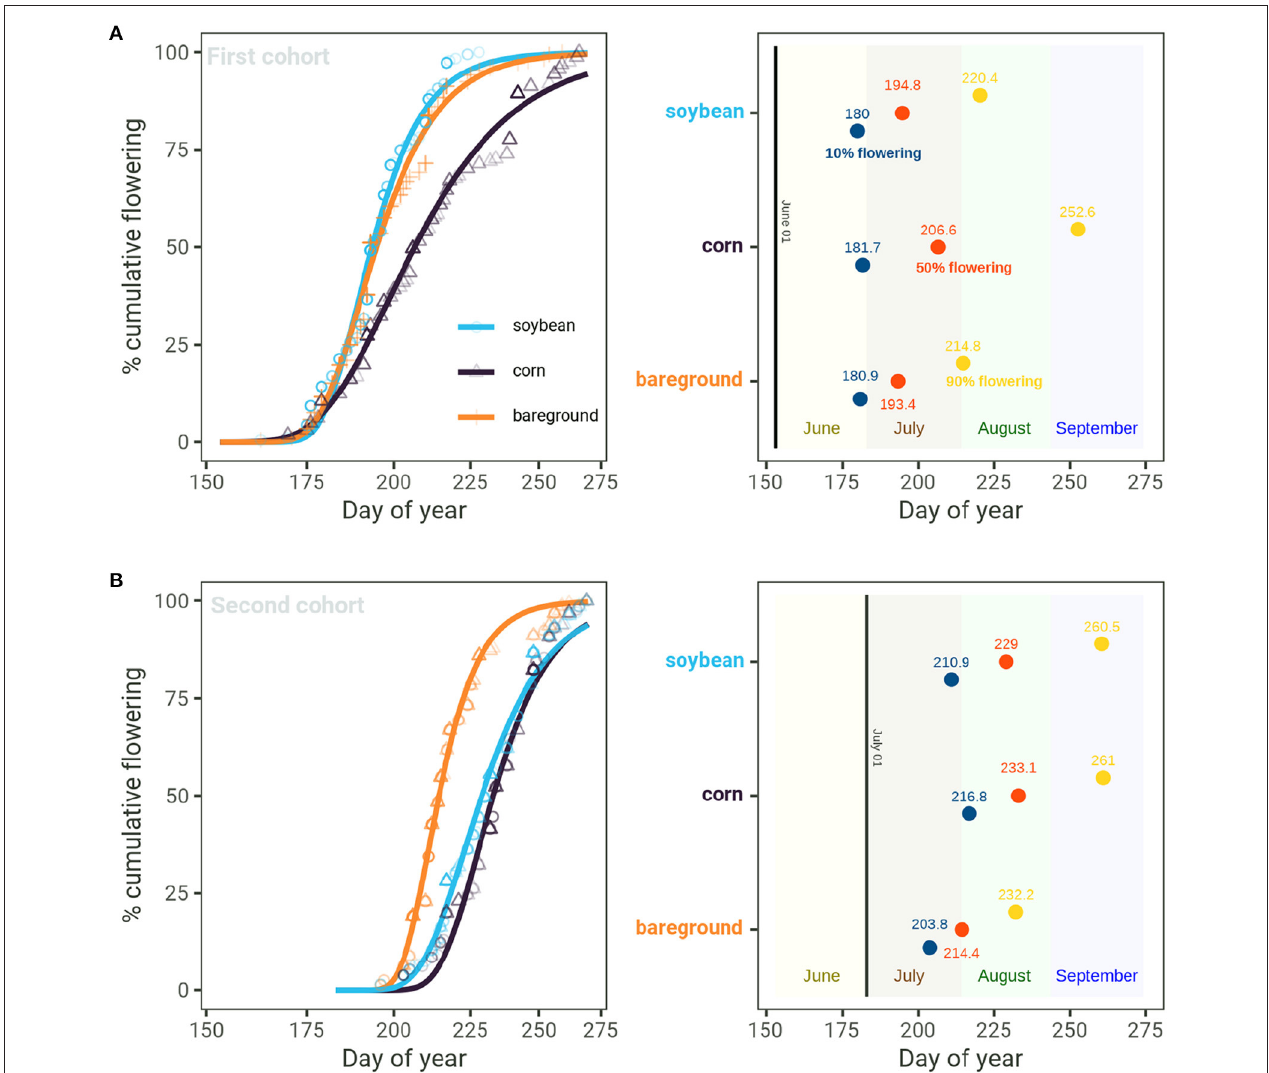
FIGURE 5 | Cumulative flowering of Palmer amaranth at first and second transplant timing (A) and day of year (doy) of 10, 50, and 90 cumulative flowering at first and second cohort transplanting time (B) nested across Arlington, WI, Clay Center, NE, Grant, NE, Lincoln, NE, and Macomb,